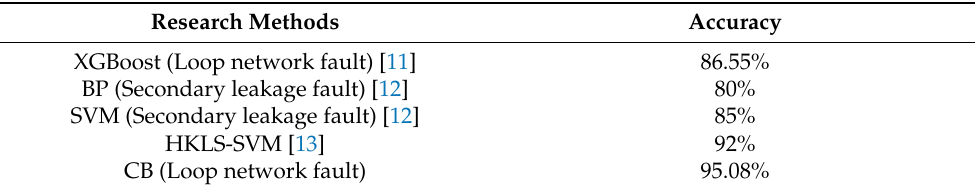
Table 3. Accuracy comparison of different research